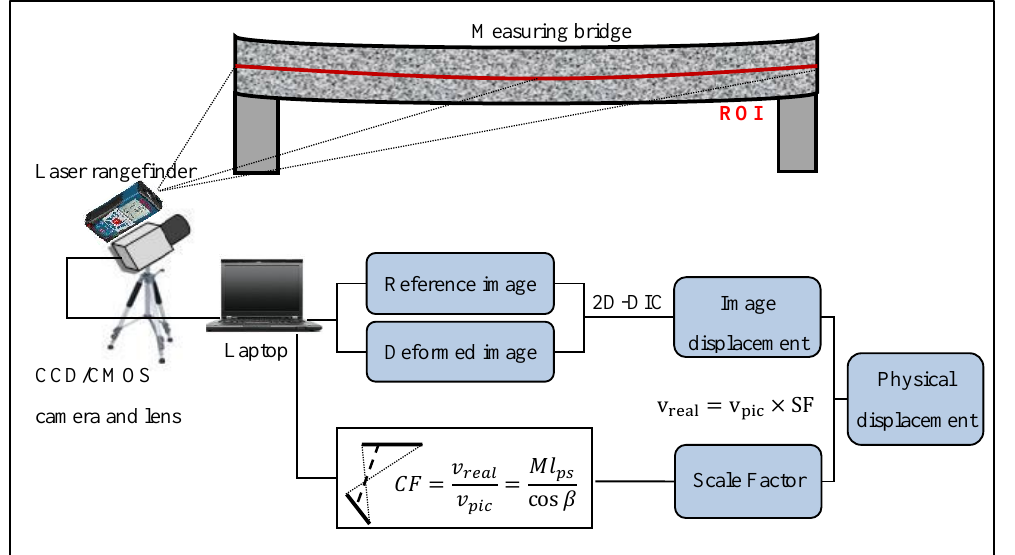
Figure 2. Schematic of full-field bridge deflection measurement.